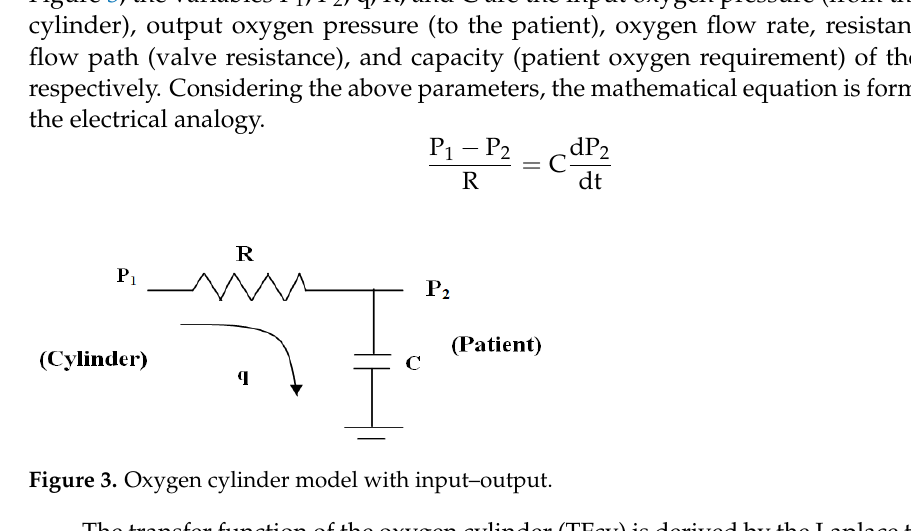
Figure 3. Oxygen cylinder model with input–output.